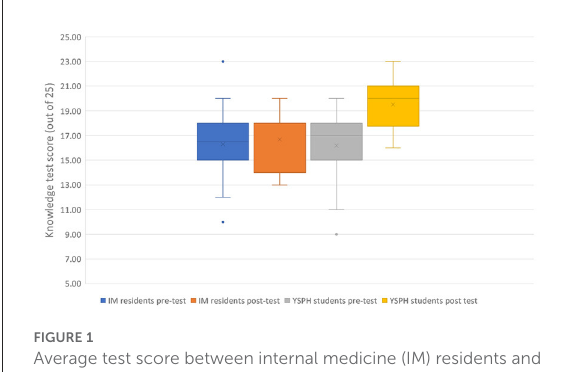
FIGURE1 Average test score between internal medicine (IM) residents and Yale School of Public Health (YSPH) students before and after the